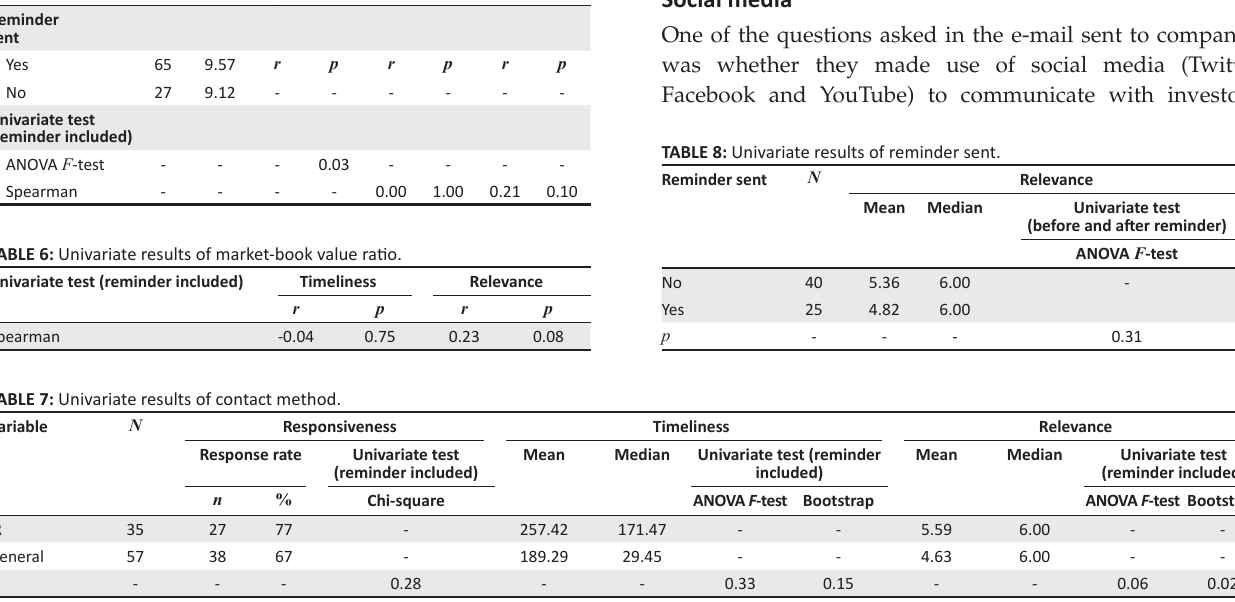
TABLE 5: Univariate results of company size. Variable N Mean Responsiveness Timeliness